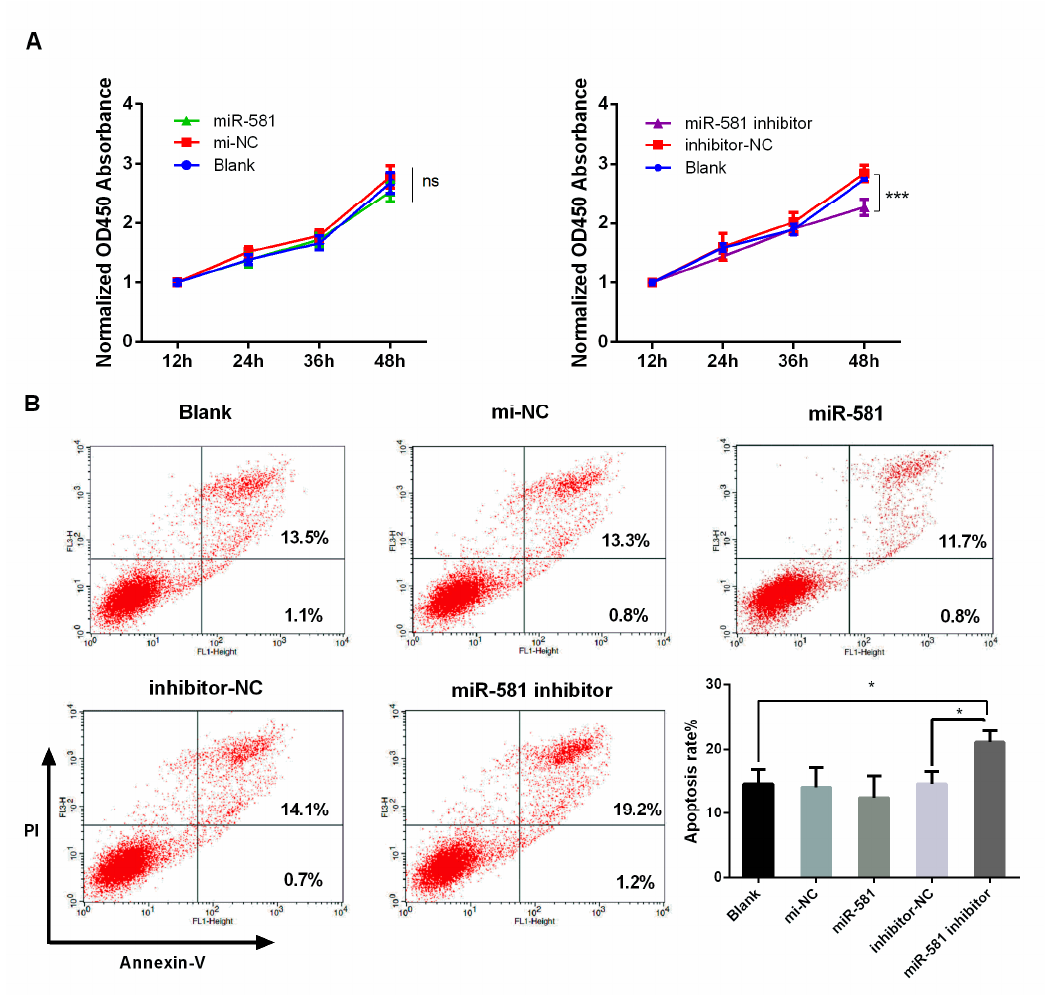
Figure 4. MiR-581 inhibition suppressed cell proliferation and induced apoptosis. ( A ). CCK-8 analysis of cell viability of SW480 cells overexpressing or knocking down miR-581. ( B ) Cell apoptosis was detected by flow cytometry. * p < 0.05 and *** p < 0.001.